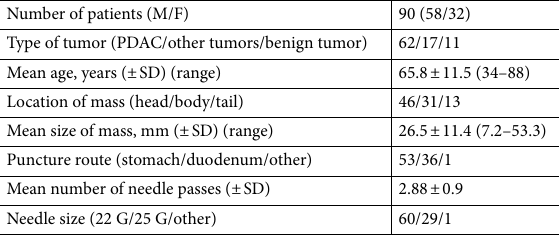
Table 1. Patients’